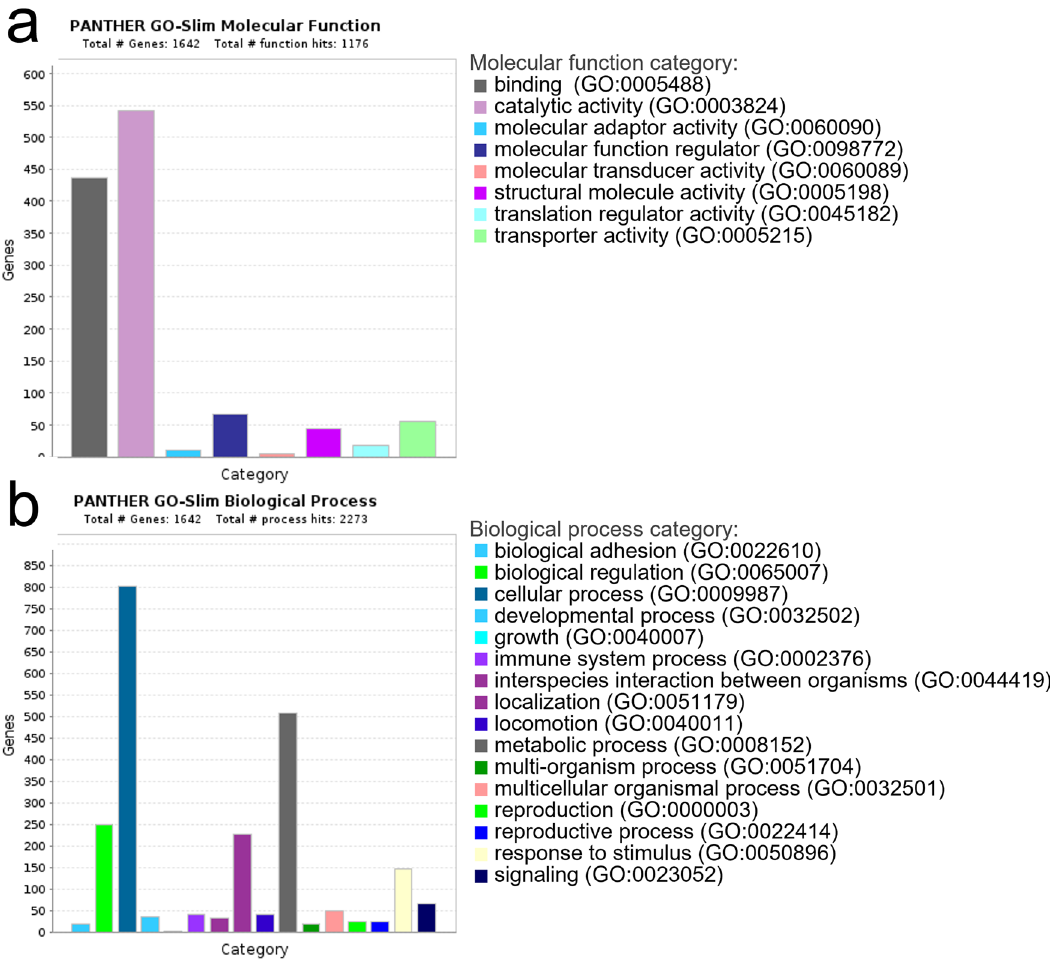
Fig. 2 Graphic PANTHER analysis view of identi fi ed zincoproteins. a Molecular function and b biological process are shown. For clarity, only high-level (level 0) categories are displayed. More detailed graphical presentations, including sub-level (level 1) are shown in Figs. S2 and S3, as well as in Supplementary Data